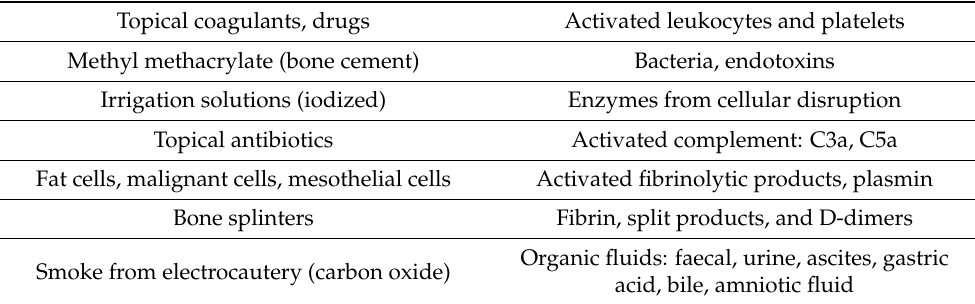
Table 1. Substances Not Suitable for Reinfusion. Topical coagulants, drugs Activated leukocytes and platelets Methyl methacrylate (bone cement) Bacteria, endotoxins Irrigation solutions (iodized) Enzymes from cellular disruption Topical antibiotics Activated complement: C3a, C5a Fat cells, malignant cells, mesothelial cells Activated fibrinolytic products, plasmin Bone splinters Fibrin, split products, and D-dimers Organic fluids: faecal, urine, ascites, gastric Smoke from electrocautery (carbon oxide) acid, bile, amniotic